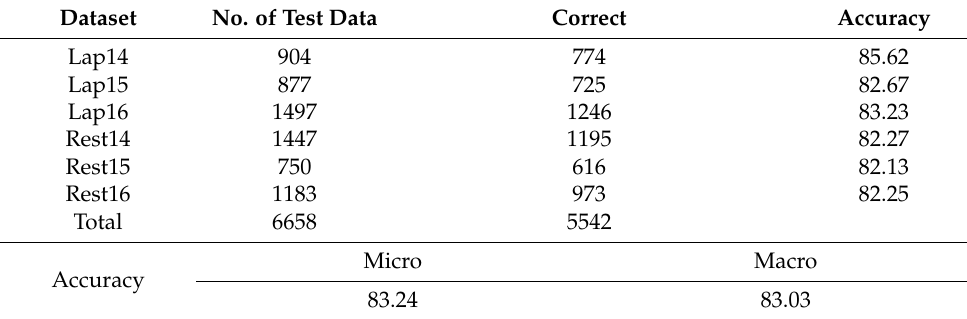
Table 3. Performance for sentiment word extraction (Task 1).